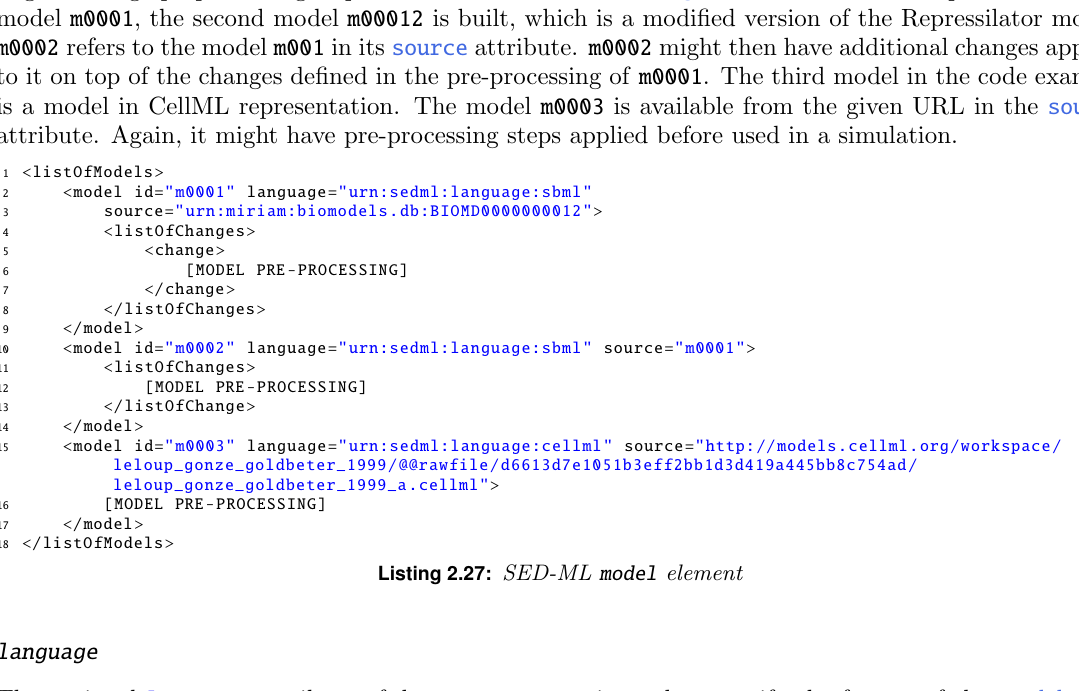
available from urn:miriam:biomodels.db:BIOMD0000000012 . For the SED-ML simulation the